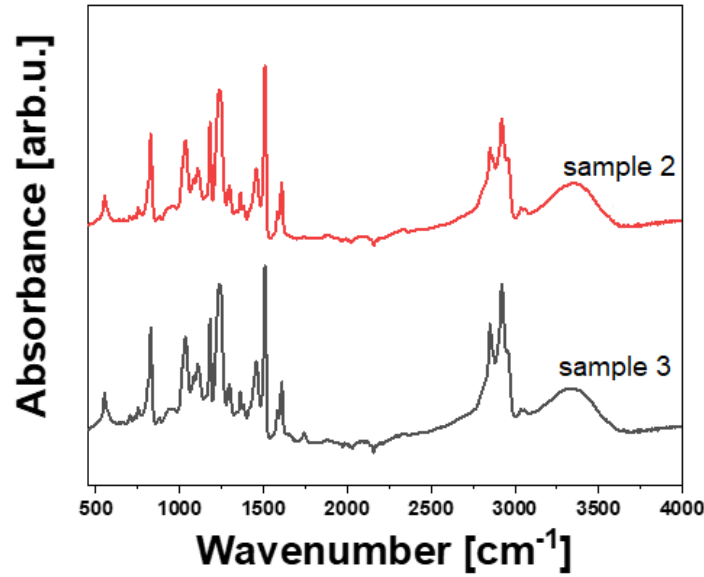
Figure 6. FT–IR spectra of the examined CFRP Figure 6. FT −−IR spectra of the examined CFRP laminates.